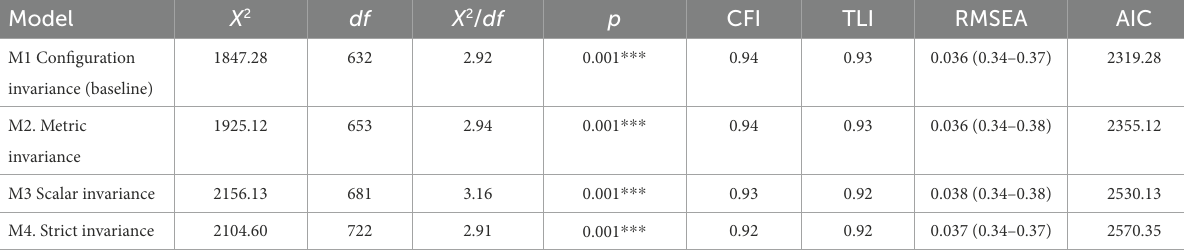
TABLE 2 Factor invariance across the gender